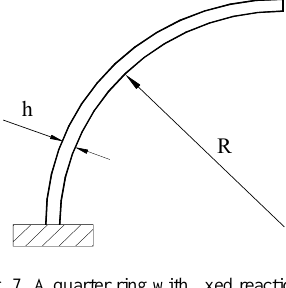
Fig. 7. A quarter ring with fixed